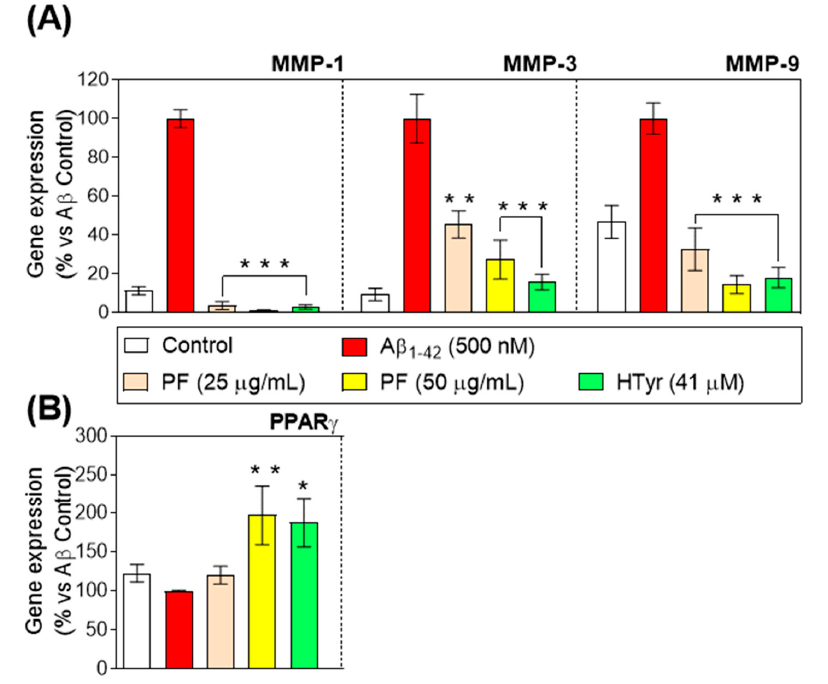
Figure 4. Relative gene expression of ( A ) MMP-1, MMP-3, and MMP-9 and ( B ) PPAR- γ in A β 1-42 - stimulated primary human neutrophils treated with the PF from VOO (25 and 50 µ g/mL) or hy- droxytyrosol (HTyr, 41 µ M) for 6 h. Values are means of the three independent experiments in triplicate, with their standard errors represented by vertical bars (* p < 0.05; ** p < 0.01; *** p < 0.001 vs. A β 1-42 -treated cells).